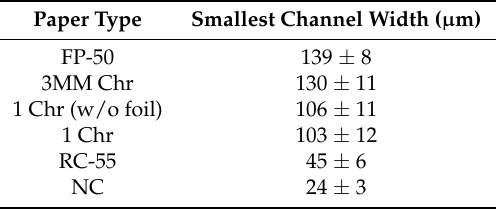
Table 1. Smallest channel widths for successful fluid flow for five different commercially